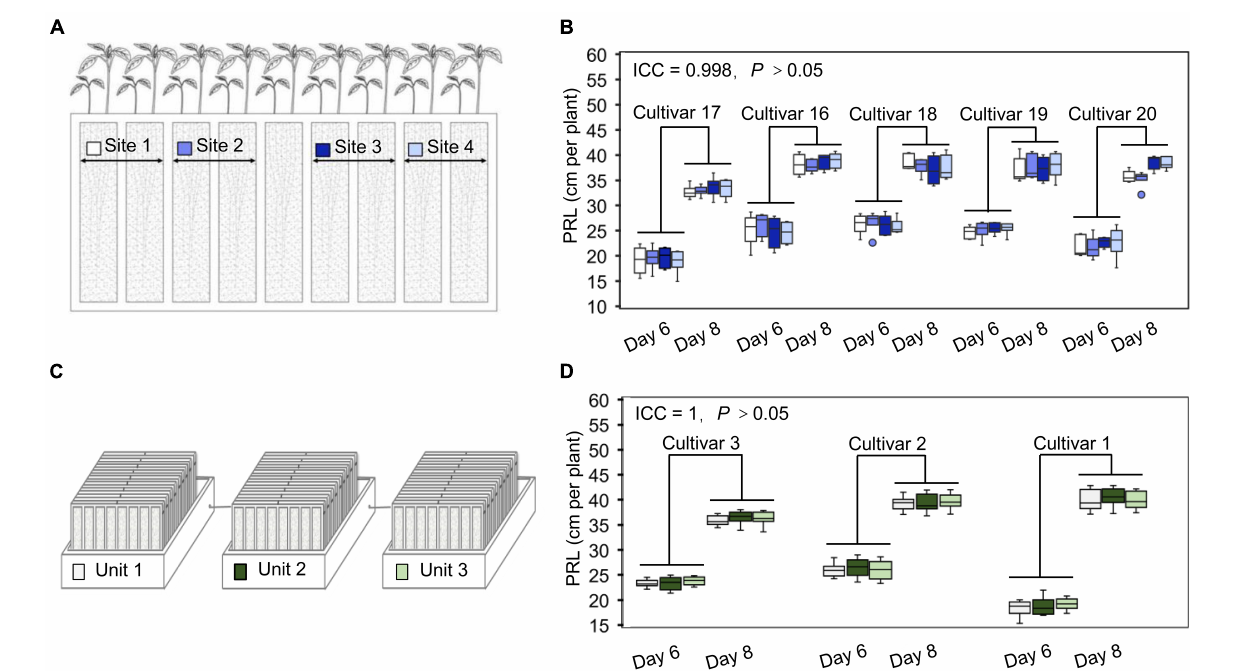
FIGURE 3 | The WinRoots system provides high uniformity of conditions between culture sites. (A) The different positions in each culture case are assigned a site number from 1 to 4, with each site supporting the growth of at least 10 soybean seedlings. (B) Primary root length (PRL) of soybean seedlings growing in different sites within the same culture case for 6 or 8 days. (C) Three culture units under normal conditions are assigned a number from 1 to 3. Each unit contains nine culture cases. (D) PRL of soybean seedlings growing in different units under normal conditions for 6 or 8 days. ICC, intraclass correlation coefficient; P , P -value.